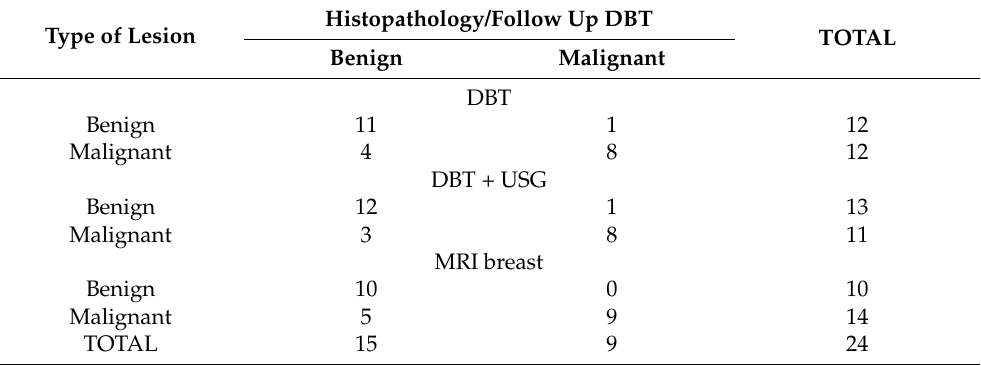
Table 3. Comparison of MRI breast, DBT + USG and DBT alone compared to HPE result or follow up DBT. Type of Lesion